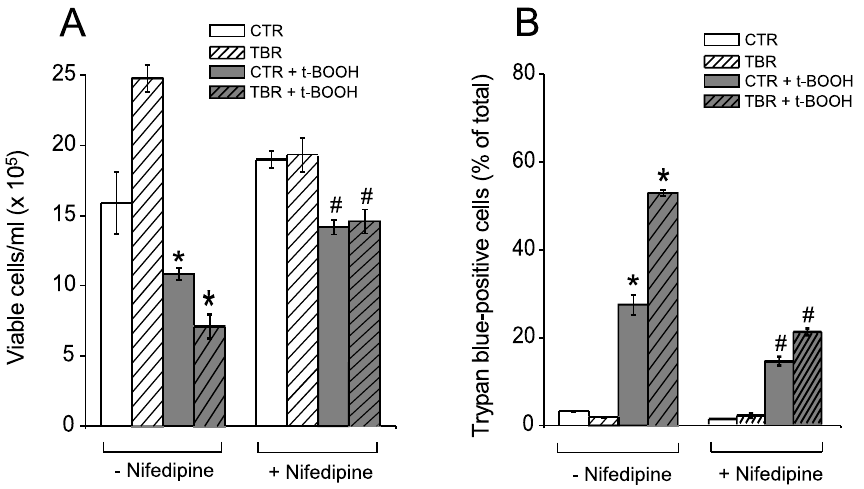
Fig. 4 – t-BOOH-induced death of CTR and TBR lymphocytes is prevented by nifedipine. (A) Growth of nifedipine-treated CTR (white and gray bars) and TBR lymphocytes (white hatched and gray hatched bars) incubated for 4 h in the absence of 500 µ M t-BOOH (white and white hatched bars) or in its presence (gray and gray hatched bars). (B) Death of nifedipine-treated CTR and TBR lymphocytes incubated for 4 h in the absence of 500 µ M t-BOOH or in its presence. *p < 0 . 05 vs respective group without t-BOOH in the absence of nifedipine. # p < 0 . 05 vs. respective group treated with t-BOOH in the absence of nifedipine.